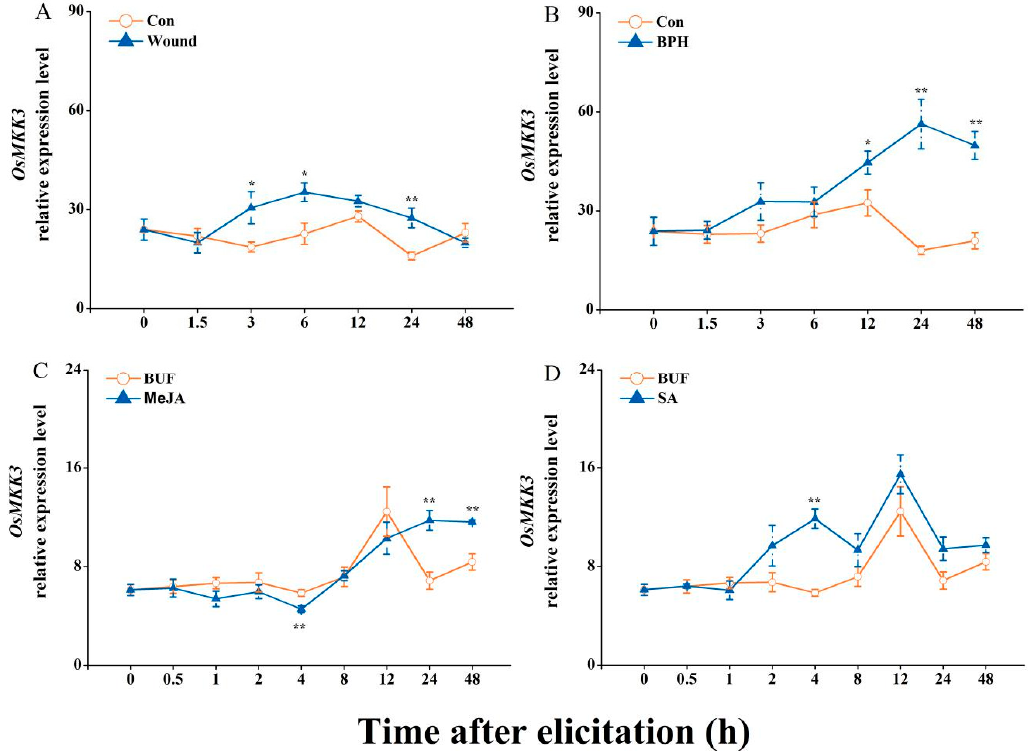
Figure 1. OsMKK3 expression levels that were elicited by multiple treatments in wild-type rice. OsMKK3 expression levels (mean ± SE, n = 6) in rice sheaths treated with mechanical wounding (Wound) ( A ), brown planthopper (BPH) infestation ( B ), methyl jasmonate (MeJA) ( C ), and salicylic acid (SA) ( D ) were analyzed by qRT-PCR. Con, non-treated plant, BUF, plant which absorbs buffer as mock. *(asterisk) show significant differences among control and treatments (*, p < 0.05; and **, p < 0.01, Student’s t